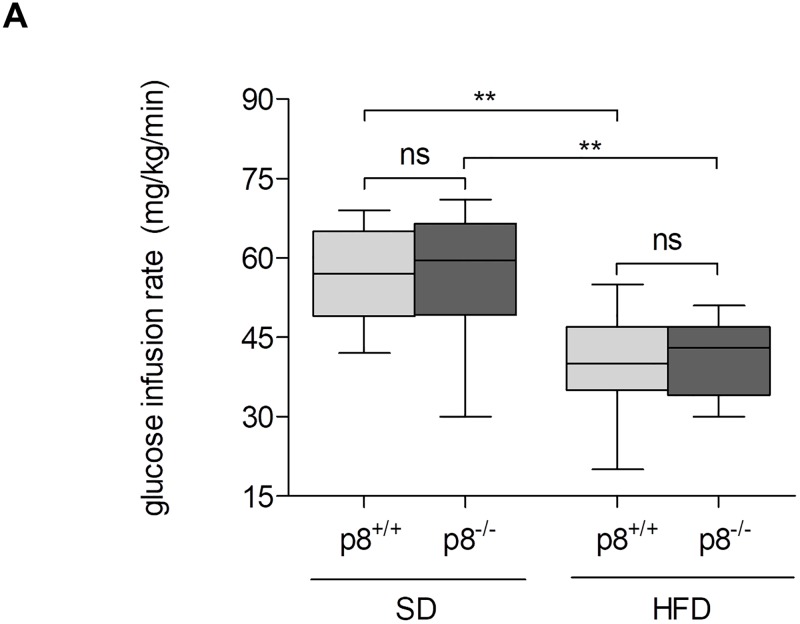
Hyperinsulinemic-euglycemic clamp.A, Hyperinsulinemic-euglycemic clamp tests were performed in both groups to analyze insulin resistance. Mice were allowed to maintain steady state after basal infusion of 75 min. Then, insulin perfusion was started at a rate of 40mU/kg/min. Additionally, 20% glucose was infused to maintain blood glucose at euglycemic levels (6.7–7.8 mmol/l) and glucose infusion rate (GIR) was determined. In both p8+/+ and p8-/-, HFD induced insulin resistance indicated by significantly reduced GIR. However, neither in SD no in HFD, calculation of GIR showed statistically significant differences between p8-/- mice and their wild type littermates (A). Results are expressed as mean ± S.D. of 12 animals (6 male, 6 female) per group. ** P<0.01.